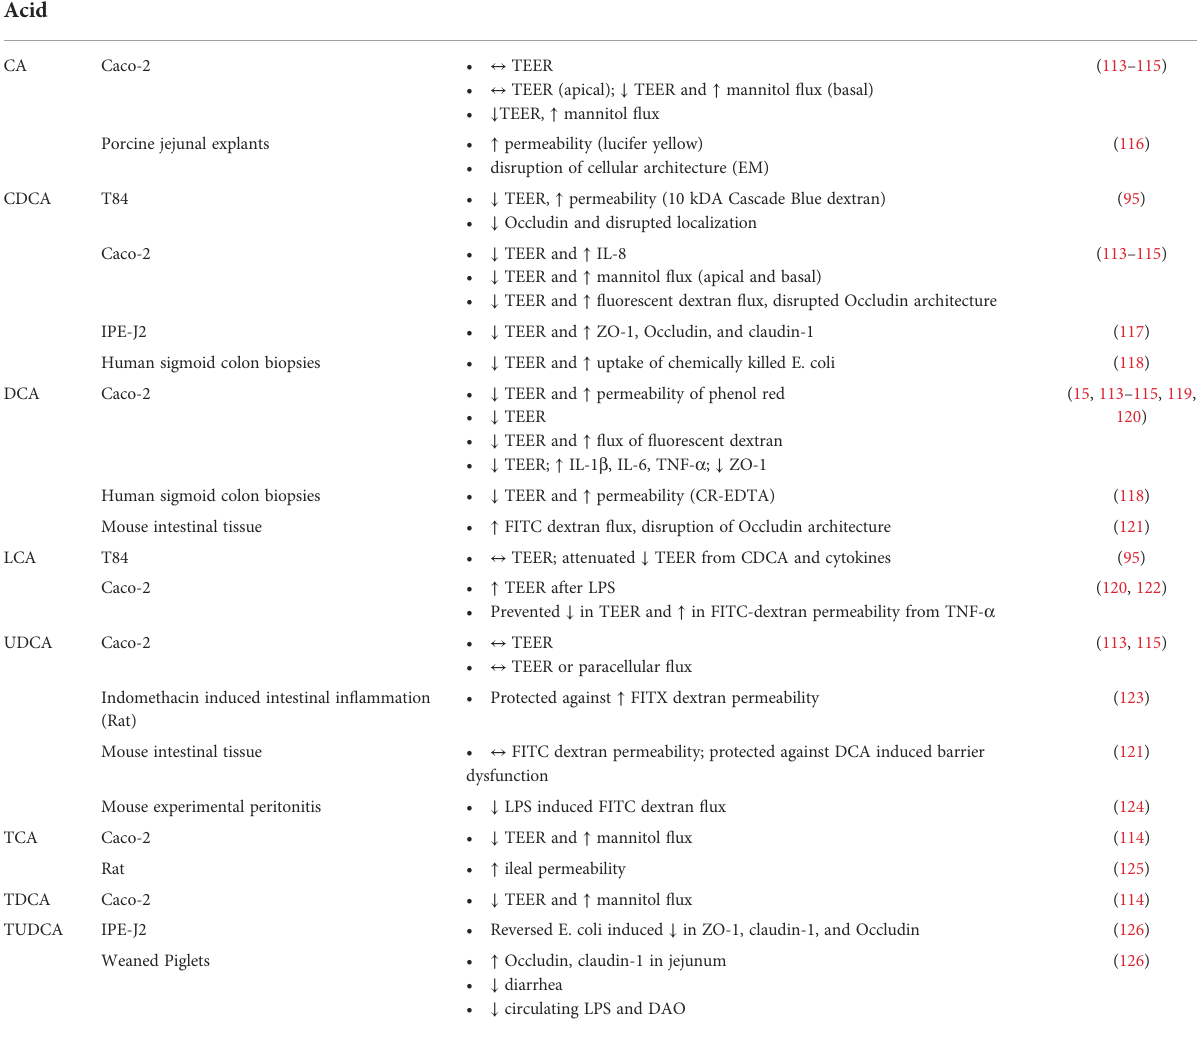
TABLE 4 Effects of bile acids on intestinal